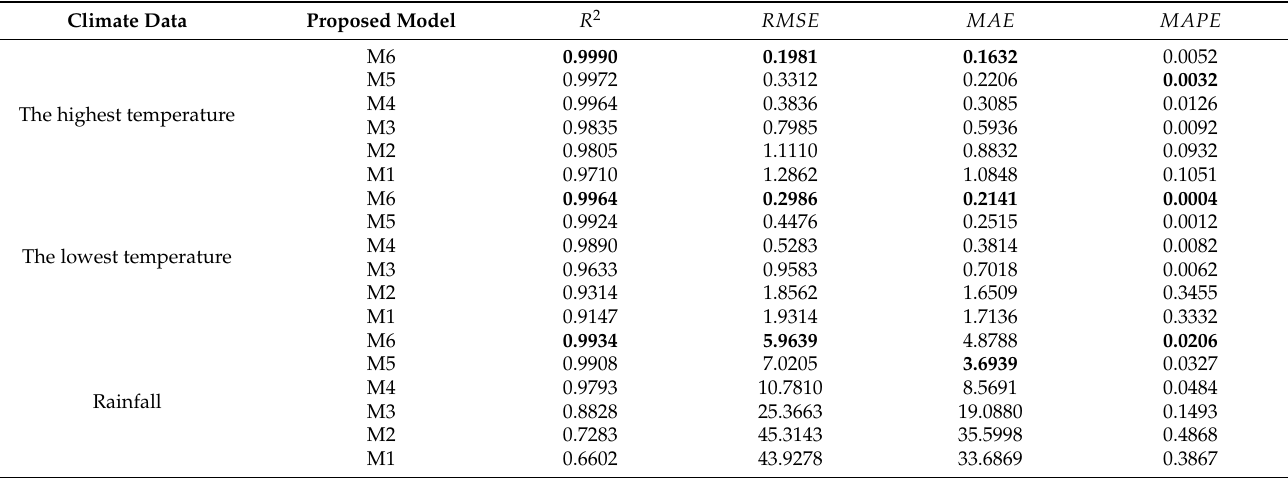
Table 2. Performance evaluation indices for the six proposed models in testing